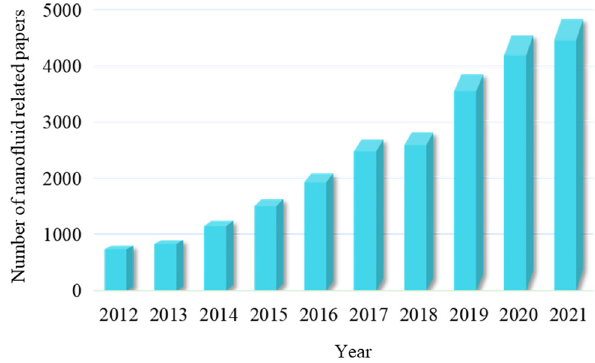
Figure 1: Number of papers on nano fl uids published reports by Web of Science.